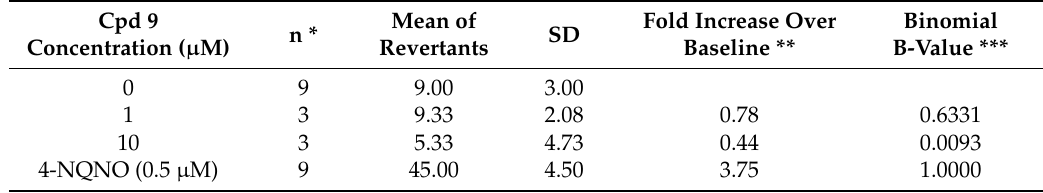
Table 7. The results of mutagenicity assay for 9 and the reference mutagen nonyl-4-hydroxyquinoline- N -oxide